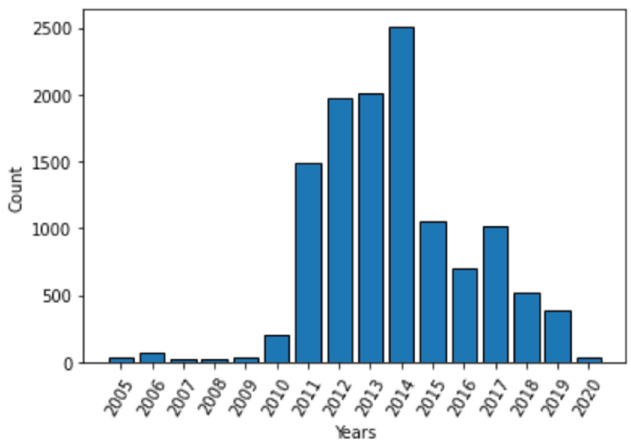
Figure 3. Number of users of the iHollaback! app since its creation.